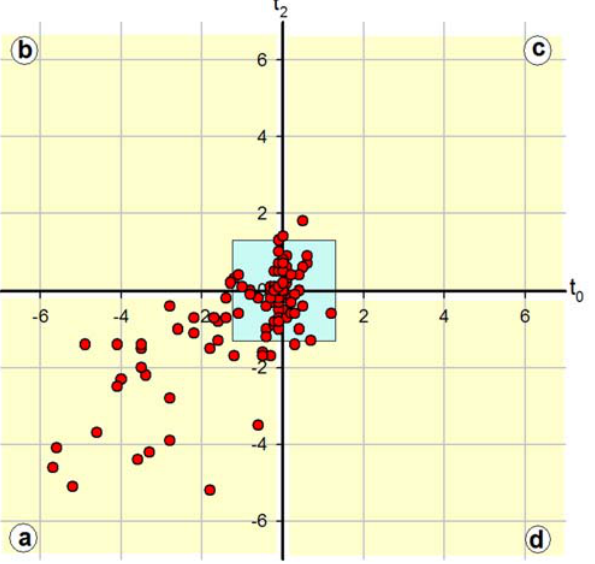
Figure 1. D plcR-wt expression ratios as determined by micro- array experiments. Ratios of expression between the wildtype strain and the delta plcR strain as determined by microarrays. The log2 of these ratios were plotted at t 2 vs t 0 . Each red circle represents the values obtained for one gene. Inside the blue square at the center of the figure are the genes for which the expression ratios were equal or less than 2. Genes for which the transcription was induced by PlcR both at t 0 and at t 2 are in the yellow square ‘a’, whereas genes induced only at t 2 or only at t 0 are in the yellow squares ‘b’ or ‘d’, respectively. Genes repressed by PlcR both at t 0 and at t 2 are in the yellow square ‘c’.